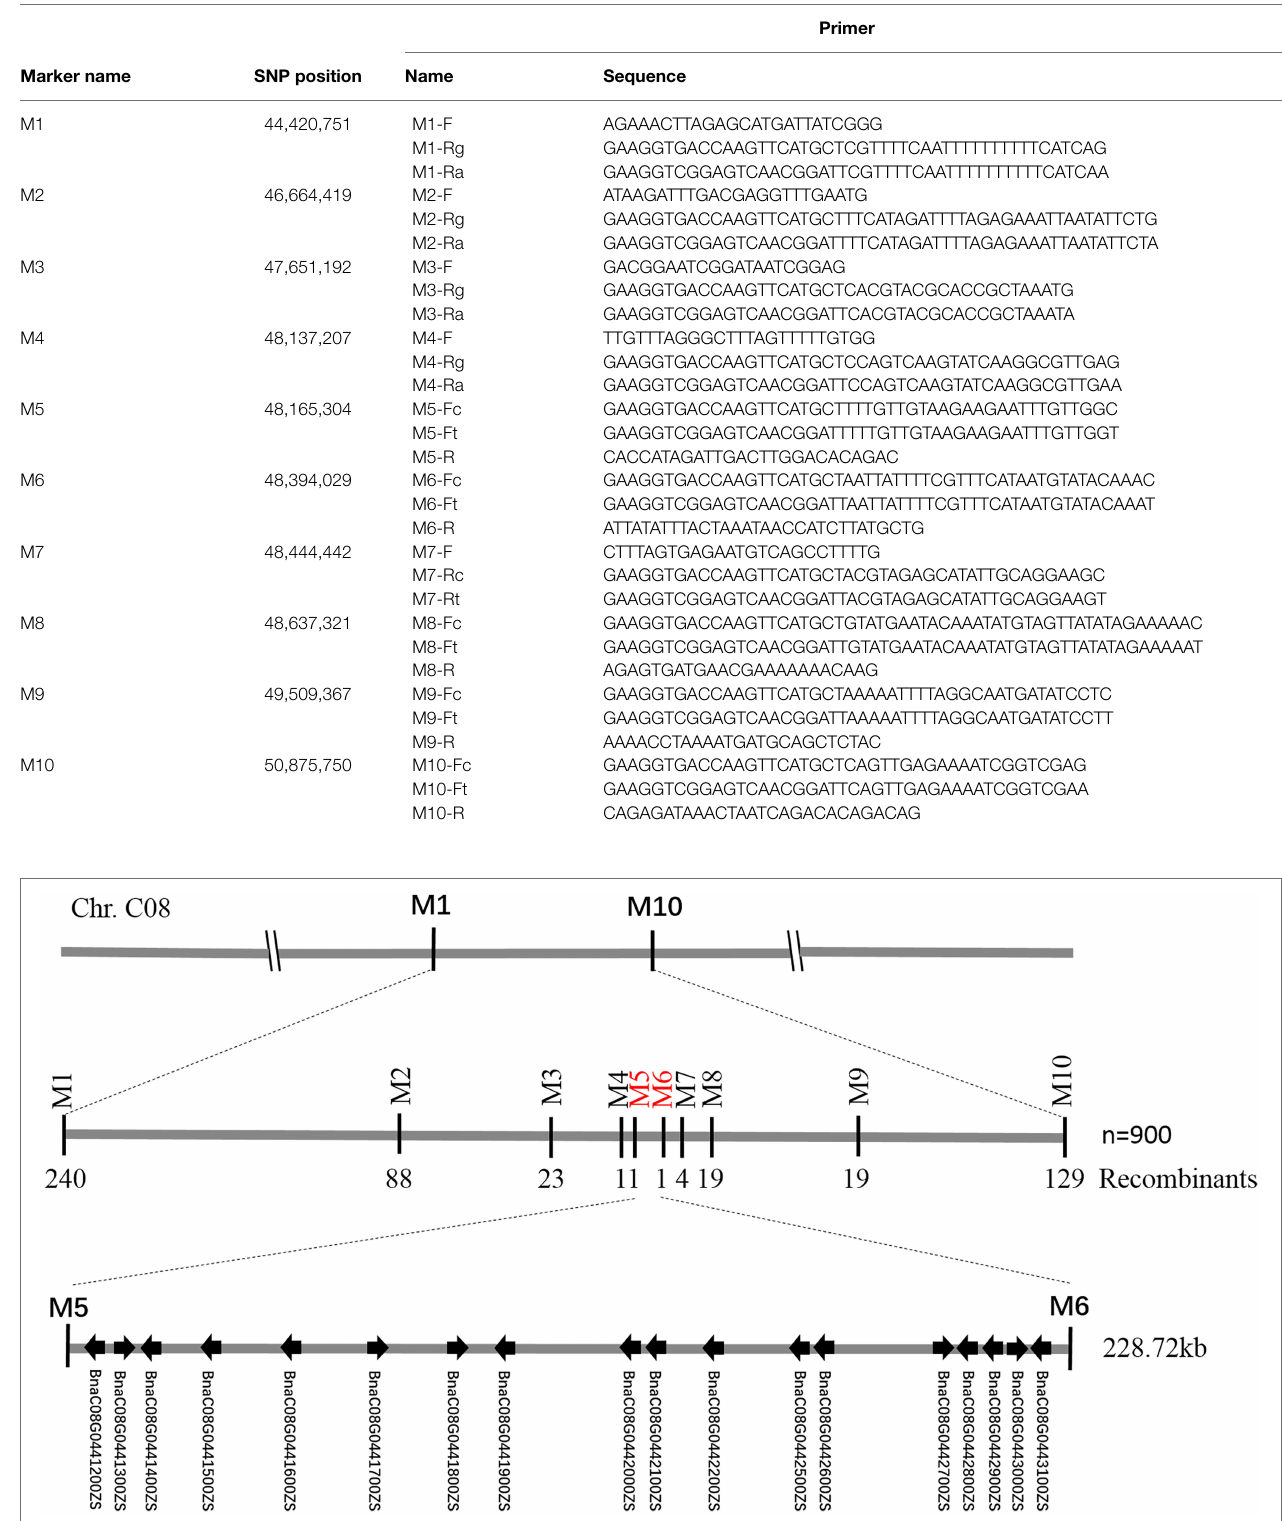
TABLE 1 | Penta-primer amplification refractory mutation system (PARMS) single-nucleotide polymorphism (SNP) markers used for fine-mapping of the BnC08.cds gene.